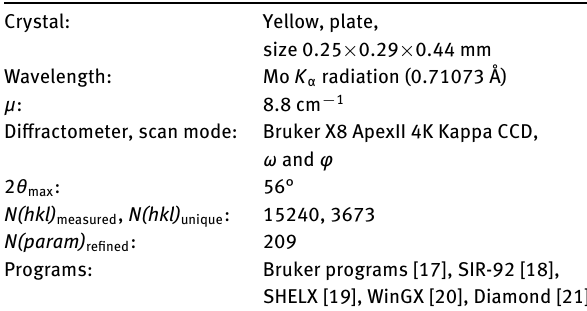
Table 1: Data collection and handling. Crystal: